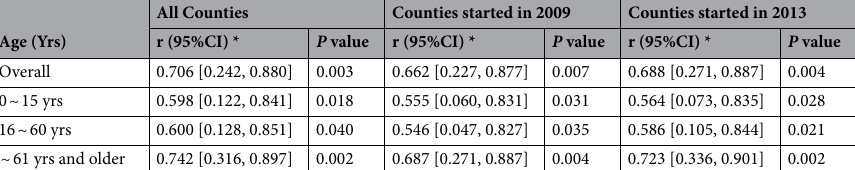
Table 2. Epidemiological correlation between human and rodent hantavirus from 2005 to 2019 in the surrounding counties of Gaoan. * Correlation coefficient was calculated based on Person test.